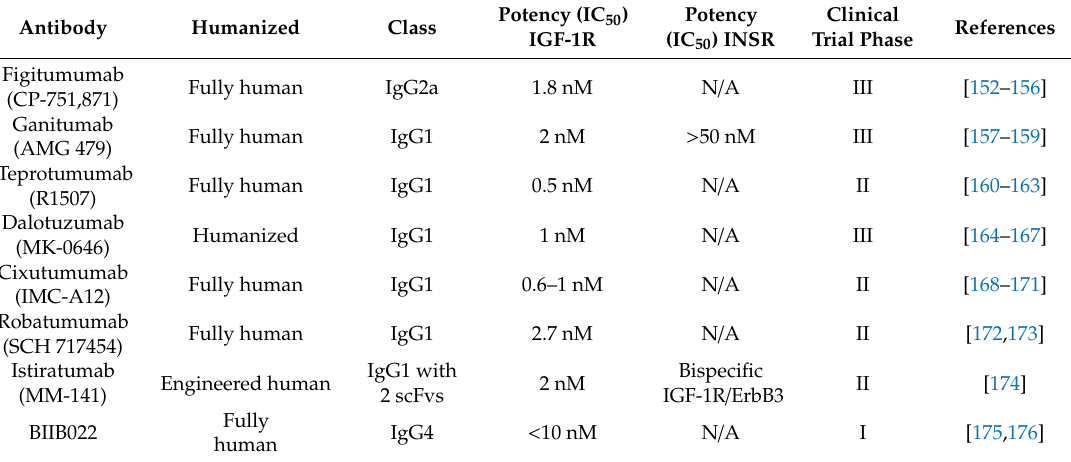
Figure 1. Overview of therapeutic strategies developed to inhibit the insulin like growth factor (IGF) axis. Figure shows the major components of the IGF axis and approaches to targeting by different classes of inhibitor. Information taken from references cited in the text. Table 1. Anti- type 1 IGF receptor (anti-IGF-1R) antibodies evaluated in clinical trials in cancer